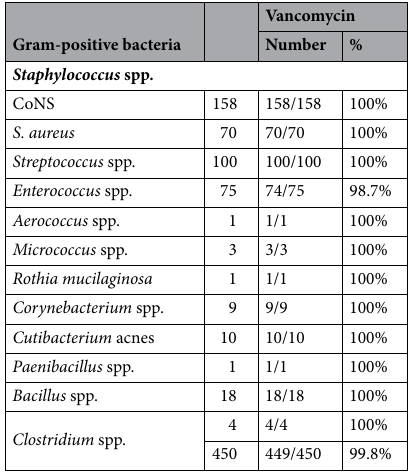
Table 2. Vancomycin susceptibility testing in Gram positive bacteria. CoNS coagulase-negative